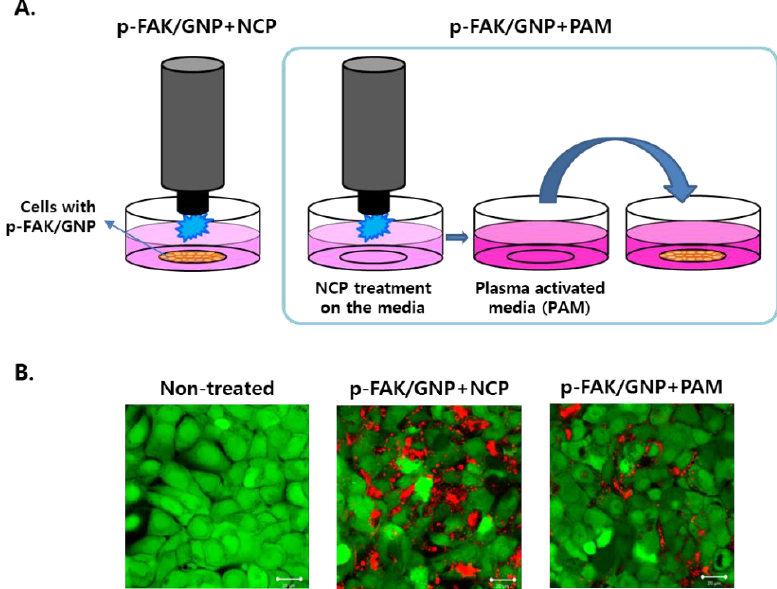
Figure 3. The direct treatment of NCP on p-FAK/GNP-treated cells induced immediate cell death, but plasma-activated media did not. ( A ) A schematic diagram describing the cell treatment methods for p-FAK/GNP+NCP and p-FAK/GNP+PAM. ( B ) The results of the live/dead assay depending on the NCP treatment methods. The SCC25 cells were pretreated with p-FAK/GNP 1 h before the NCP or PAM treatment. The photographs are representative of the 3 independent experiments. Scale bar: 20 μm.